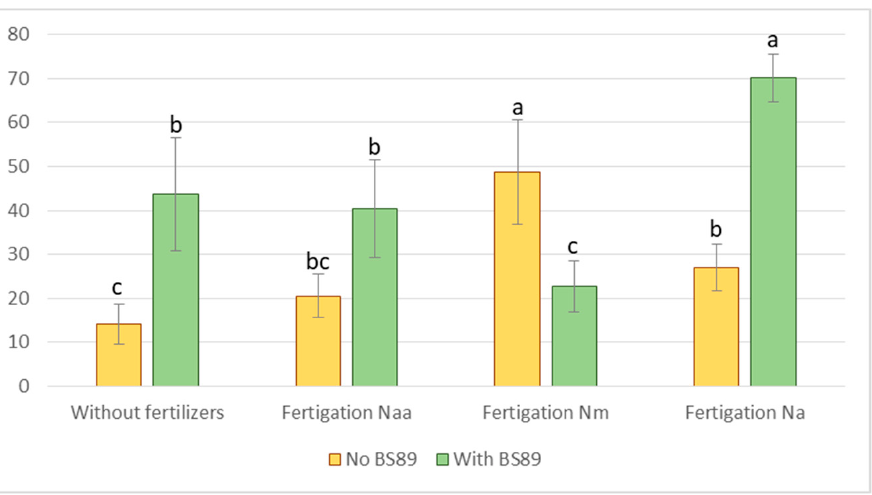
Figure 2. The effect of nitrogen fertilizers and PGPR Bacillus velezensis BS89 on runner weight of cv. Rusich strawberry plants, October 2020 (runner weight, grams). The bars are means of three replications per variant. Bars show ± SE, and different letters show a significant difference at the p ≤ 0.05 level, as determined by Duncan’s multiple tests.